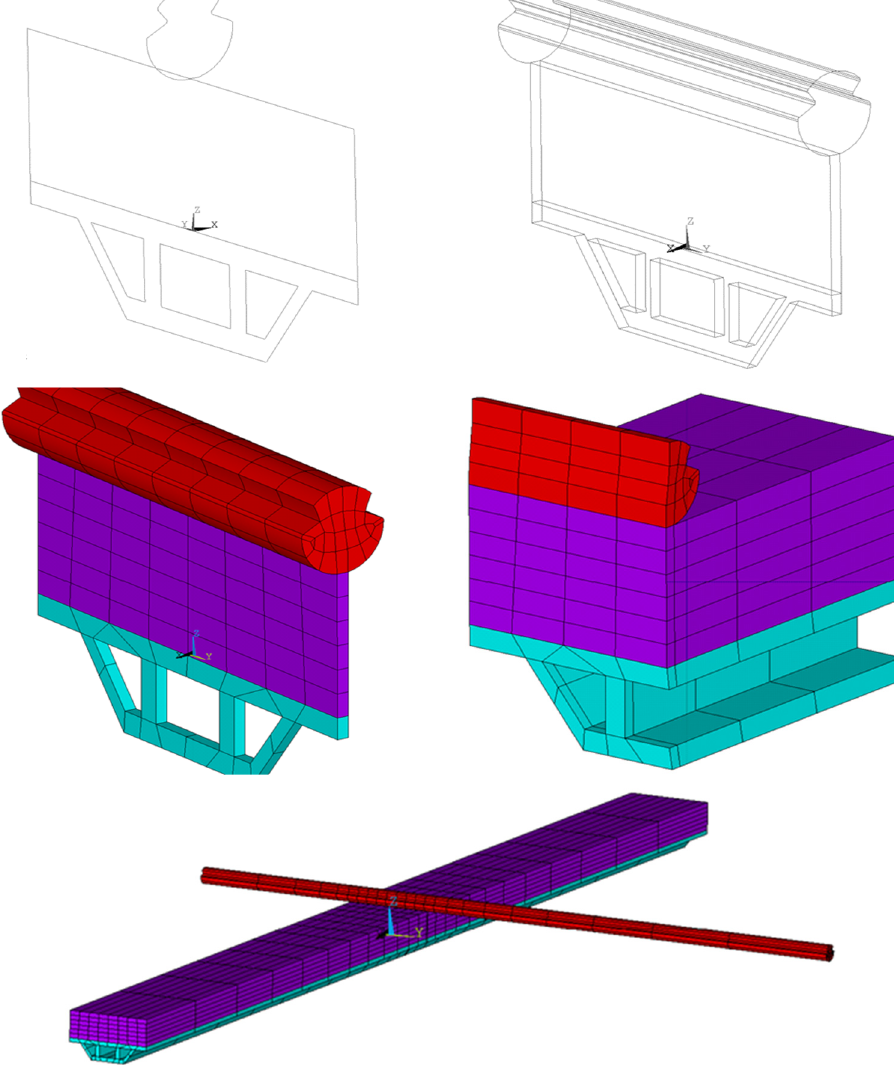
Figure 6. Fragment of contact–contact wire and contact strip–CAD model. A nonlinear elements type hexahedral with 20 nodes was used for the FEM model. This type of finite element allows for a coupled field with mechanical–thermal–electrical